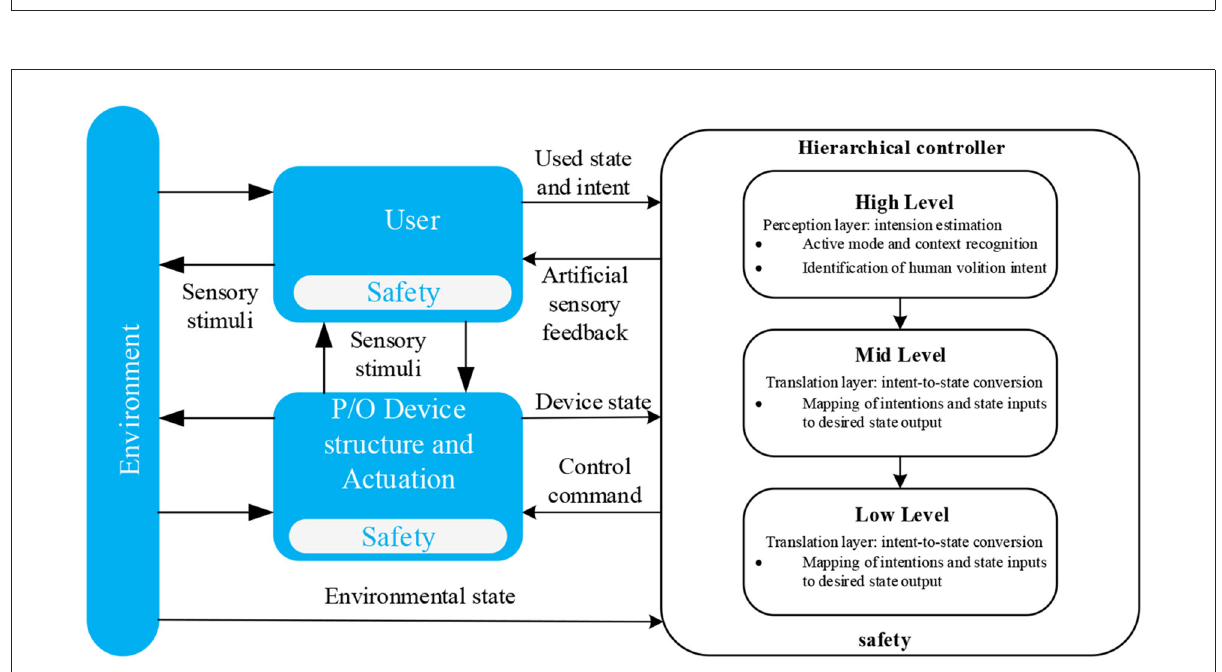
FIGURE7 Generalized control framework for lower limbs. Three stages are essential for LLEC: high-level, mid-level, and low-level. First, the layer accomplishes action mode recognition on the high-level stage, enabling the controller to switch between mid-level controllers suitable for various locomotive duties, such as level walking, stair ascent, standing, hopping, and so on. Second, at the mid-level stage, a layer converts human intentions into instructions or estimate points that are then transferred to local controllers, each placed at every linkage of the exoskeleton. Finally, in the low-level stage, the layer accomplishes real-time control in each joint by performing feed-forward and feed-backward control loops ( Tucker et al.,